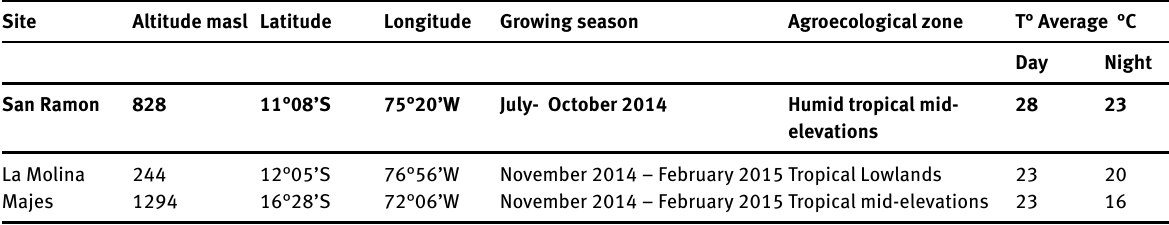
Table 1: Experimental sites in Perú for narrow-sense and broad-sense heritability for yield components and glycoalkaloid content Site Altitude masl